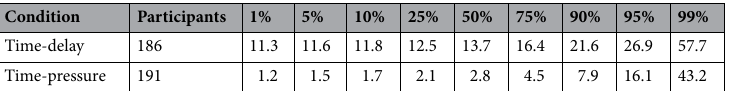
Table 15. Number of participants and response times by quantile in time-delay and time-pressure groups.